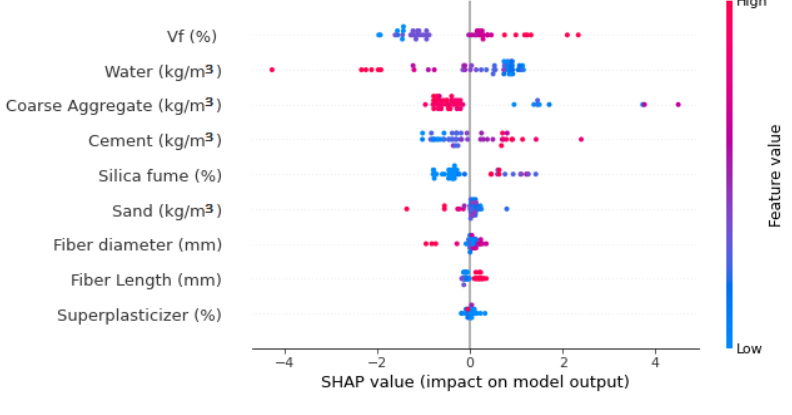
Figure 14. SHAP plot.